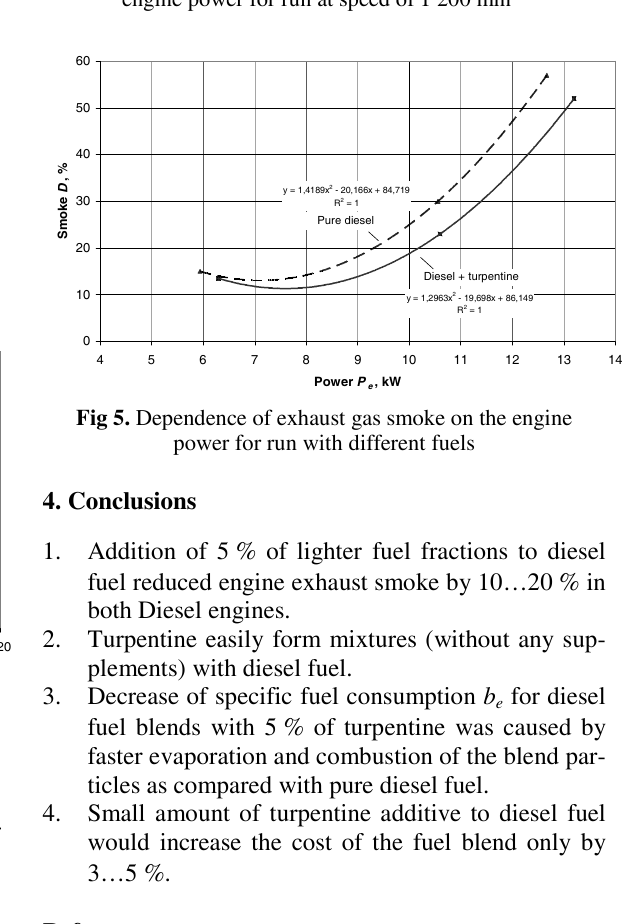
Fig 4. Dependence of fuel consumption on the engine power for run at speed of 1 200 min –1